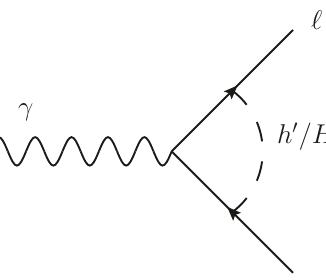
Figure 3 . One-loop contribution to lepton anomalous magnetic moments from the neutral scalars h 0 and H